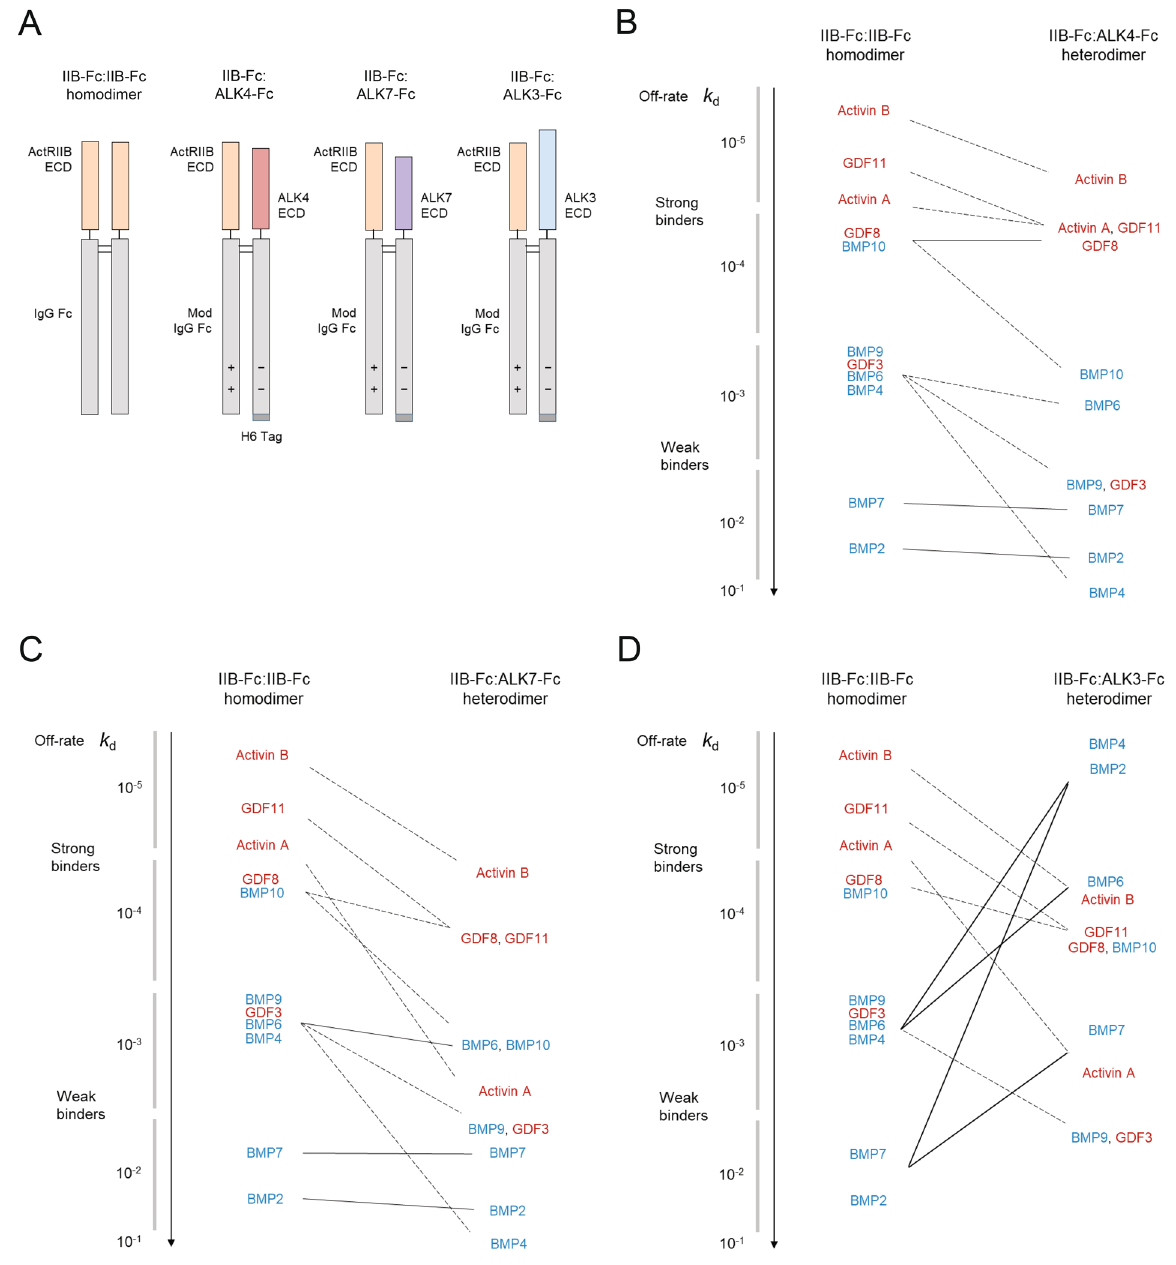
Figure 2. Profiles of ligand dissociation kinetics for heterodimeric ligand traps vary with type I receptor component. ( A ) Domain schematics depicting variants based on naturally occurring pairings of TGF-β superfamily type I receptor ECDs with ActRIIB ECD. The Fc domains of heterodimeric fusion proteins are modified (Mod) to promote desired pairing of monomers during cellular production. H6, histidine hexamer. ( B–D ) Ligand sequestration profiles for ActRIIB-Fc-based heterodimeric traps vary markedly with the identity of the partnered type I receptor ECD. Semi-schematic graphs depict the change in off-rate ( k d ) of key ligands, as determined by surface plasmon resonance (see Table 1 for exact values), when one ECD in the IIB-Fc:IIB-Fc homodimer is replaced with ALK4 ( B ), ALK7 ( C ), or ALK3 ( D